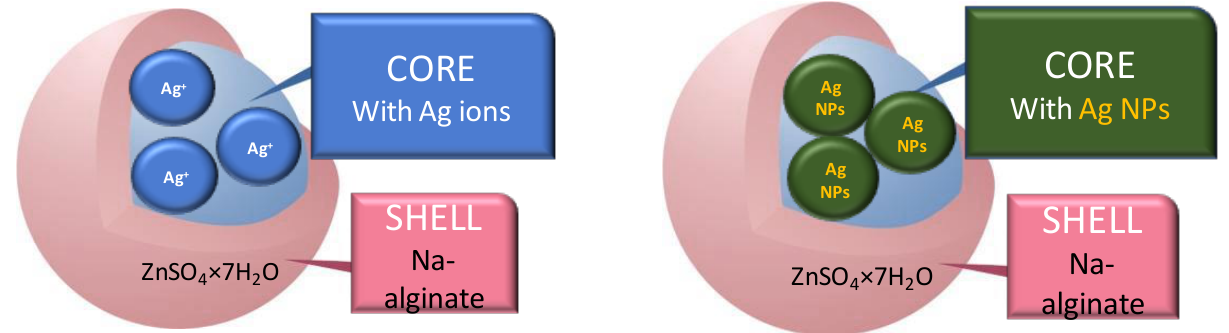
Figure 1. Graphical presentation of the structure of microcapsules that can be filled with silver ions or with silver nanoparticles, both having applications in cosmetic, pharmaceutical, and textile in- dustries.